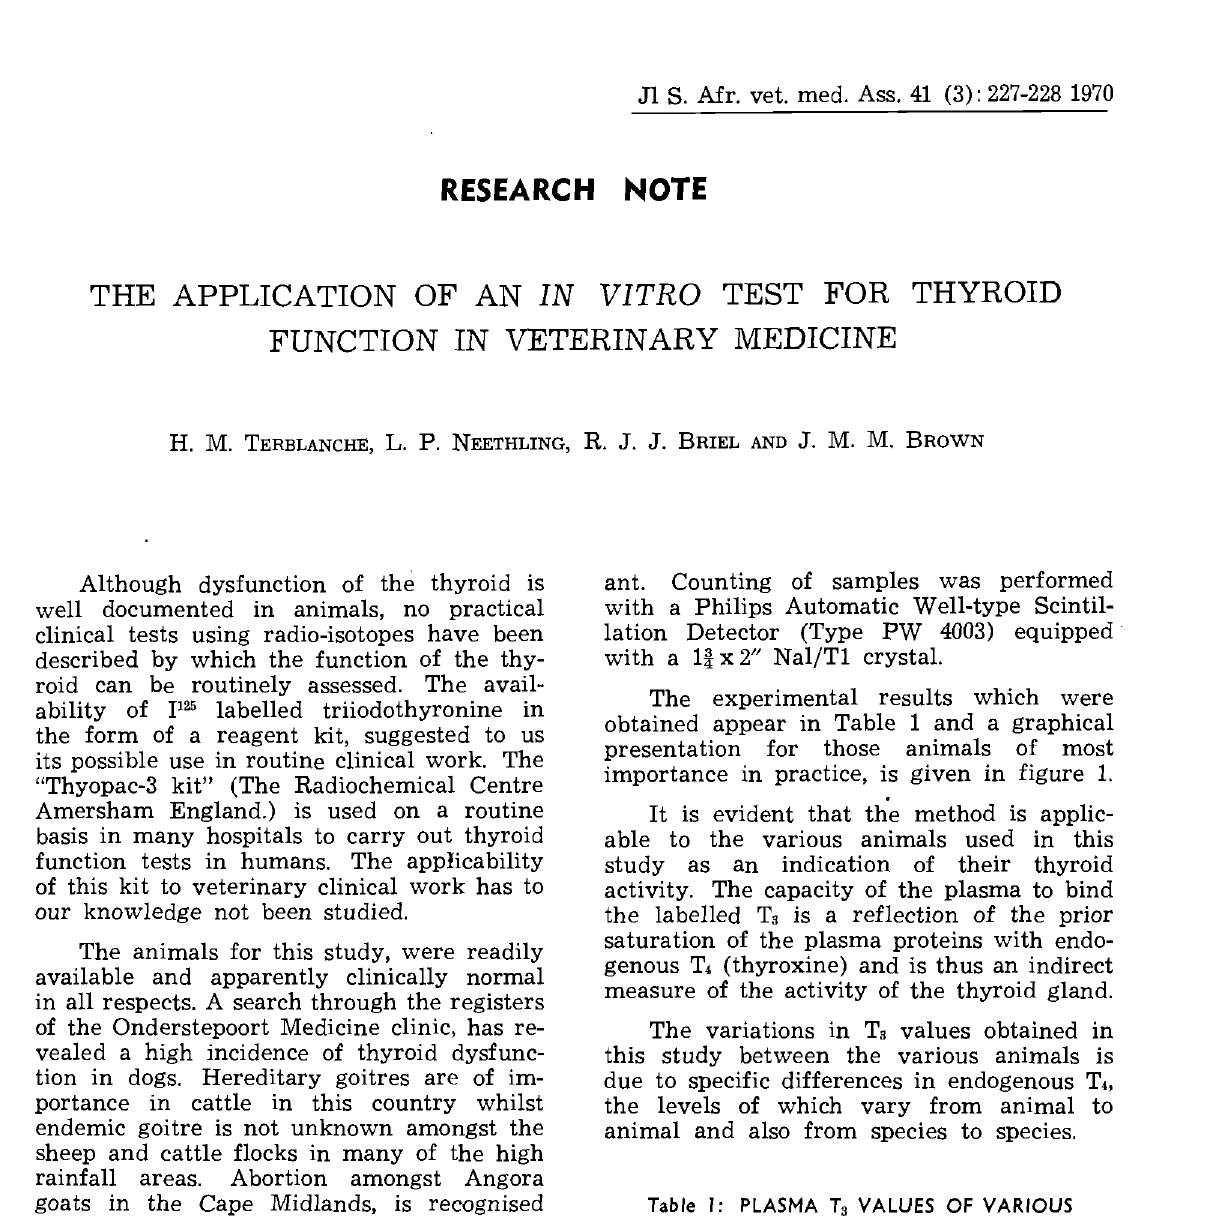
Table I: PLASMA Ts VALUES OF